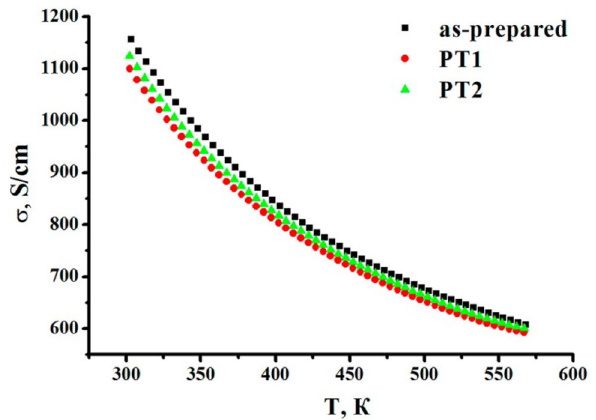
Fig. 9 The electrical conductivity as a function of temperature for as-prepared samples, after the single PT (PT1 curve) and double PT (PT2 curve) of the studied